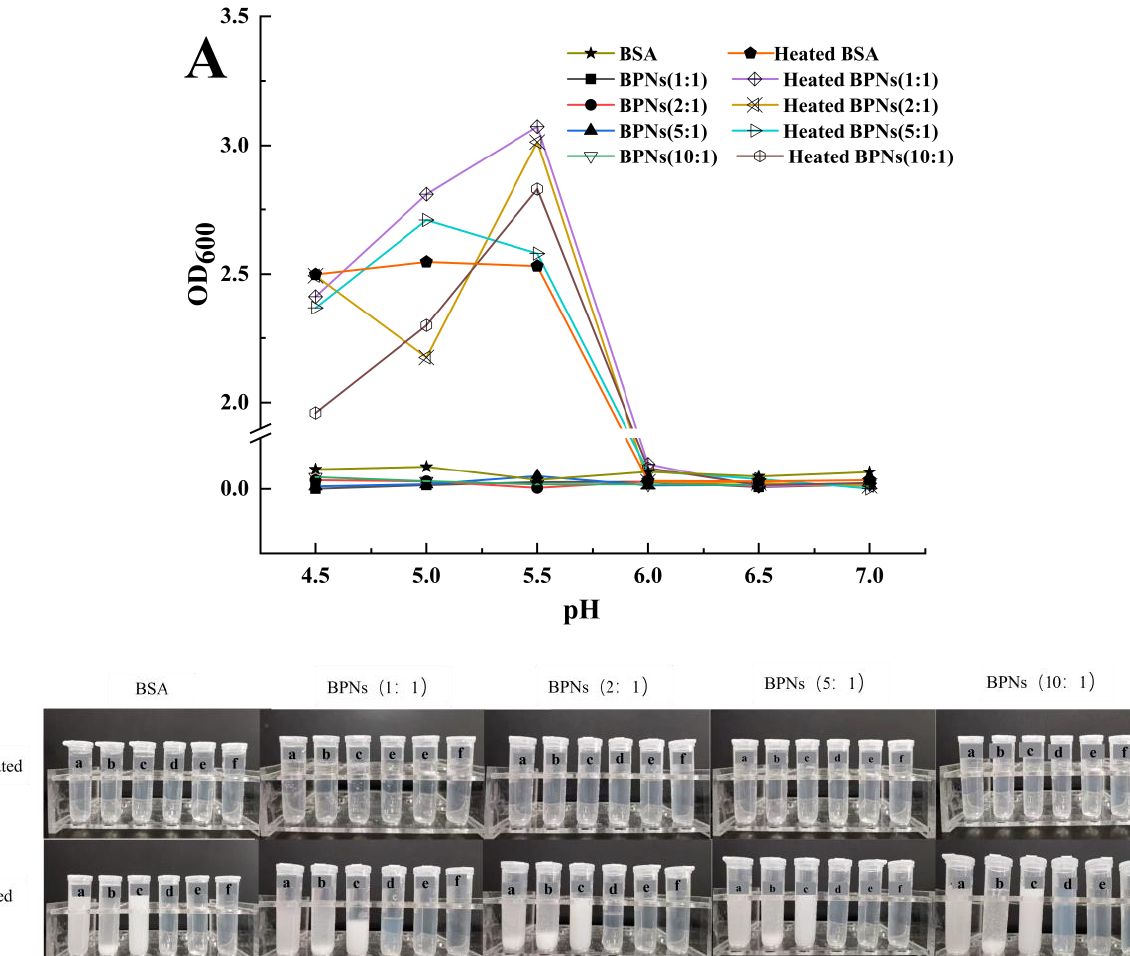
Figure 3. Turbidity curves ( A ) and visual appearance ( B ) of BSA and BPNs as a function of pH, without being heated and heated at 80 °C for 30 min. a – f represents pH 4.5, 5.0, 5.5, 6.0, 6.5, and 7.0, respectively.